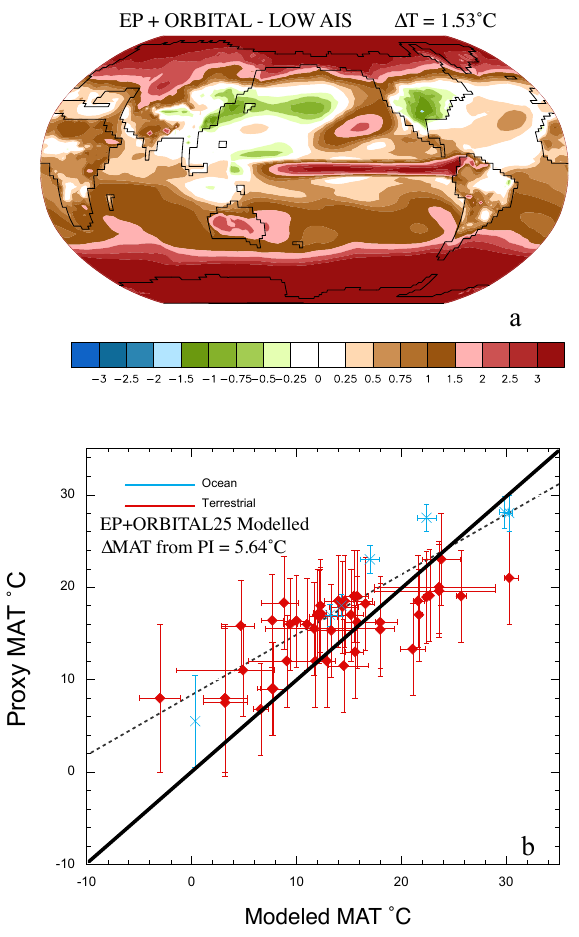
Fig. 6. (a) Modeled temperature anomaly for the EP+ORBITAL25 simulation minus the LOW AIS simulation ( ◦ C), (b) pointwise Figure DR2. a) Modelled temperature anomaly for the EP+ORBITAL25 simulation minus the LOW AIS EP+ORBITAL25 case global mean MAT compared against the Figure DR2. a) Modelled temperature anomaly for the EP+ORBITAL25 simulation minus the simulation (˚C), b) Pointwise EP+ORBITAL25 case global mean MAT compared against the proxy proxy record MAT ( ◦ C). These are the same terrestrial and SST LOW AIS simulation (˚C), b) Pointwise EP+ORBITAL25 case global mean MAT compared record MAT (˚C). These are the same terrestrial and SST records described in Figure 1. Vertical error bars records described in Fig. 1. Horizontal error bars indicate the un- against the proxy record MAT (˚C). These are the same terrestrial and SST records described in indicate the uncertainty recorded by maximum and minimum temperatures of extreme orbital obliquity certainty recorded by maximum and minimum temperatures of ex- Figure 1. Vertical error bars indicate the uncertainty recorded by maximum and minimum parameters (22˚ and 25˚ respectively). The best fit line (black dashed) is weighted to include error treme orbital obliquity as in Fig. 1. The best fit line (black dashed) temperatures of extreme orbital obliquity parameters (22˚ and 25˚ respectively). The best fit line uncertainty is fitted across all points and the y-intercept and slope reported in Table 1. is weighted to include error uncertainty fitted across all points and (black dashed) is weighted to include error uncertainty is fitted across all points and the y- Figure DR1. a) Modelled temperature anomaly for the MMCO560 (560 ppm CO 2 ) simulation the y intercept and slope reported in Table minus the MMCO simulation (˚C), b) Pointwise MMCO560 case global mean MAT compared against the proxy record MAT (˚C). These are the same terrestrial and SST records described in Figure 1. Vertical error bars indicate the uncertainty recorded by maximum and minimum temperatures of extreme orbital obliquity parameters (22˚ and 25˚ respectively). The best fit line (black dashed) is weighted to include error uncertainty is fitted across all points and the y- intercept and slope reported in Table 1.